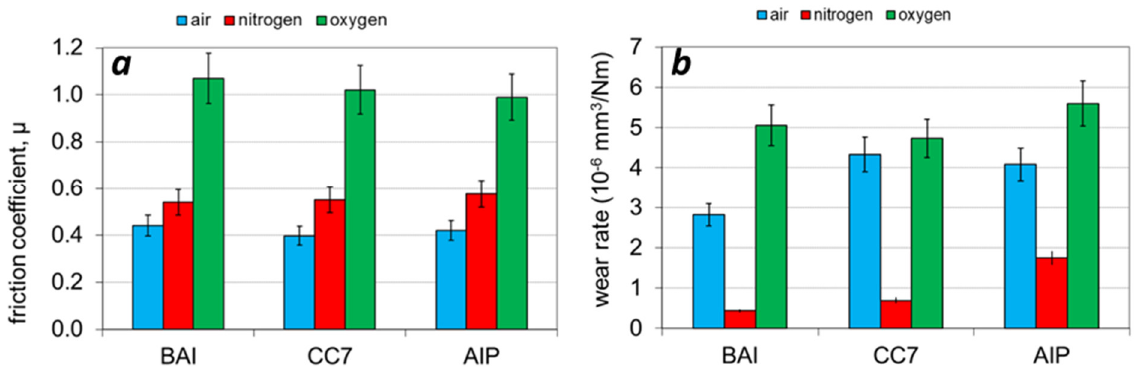
Figure 11. The friction coefficients ( a ) and the wear rates ( b ) in the ambient, oxygen and nitrogen atmospheres for three different coatings.